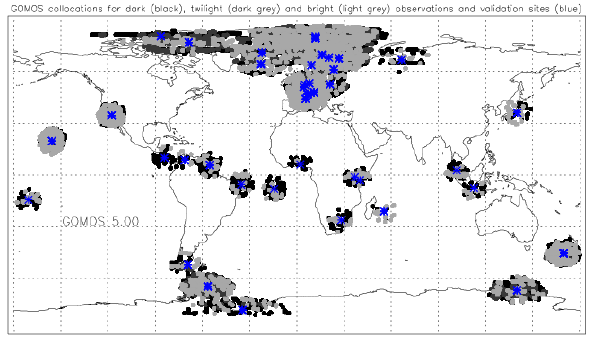
Fig. 3. Global overview of collocated measurements available in Figure 3: Global overview of collocated measurements available in this study. GOMOS 3 this study. GOMOS measurements in black (dark limb observa- measurements in black (dark limb observations), dark grey (twilight conditions) and light 4 tions), dark grey (twilight conditions) and light grey (bright limb grey (bright limb observations) circles together with the validation sites plotted as blue 5 observations) circles together with the validation sites plotted as asterisks. 6 blue